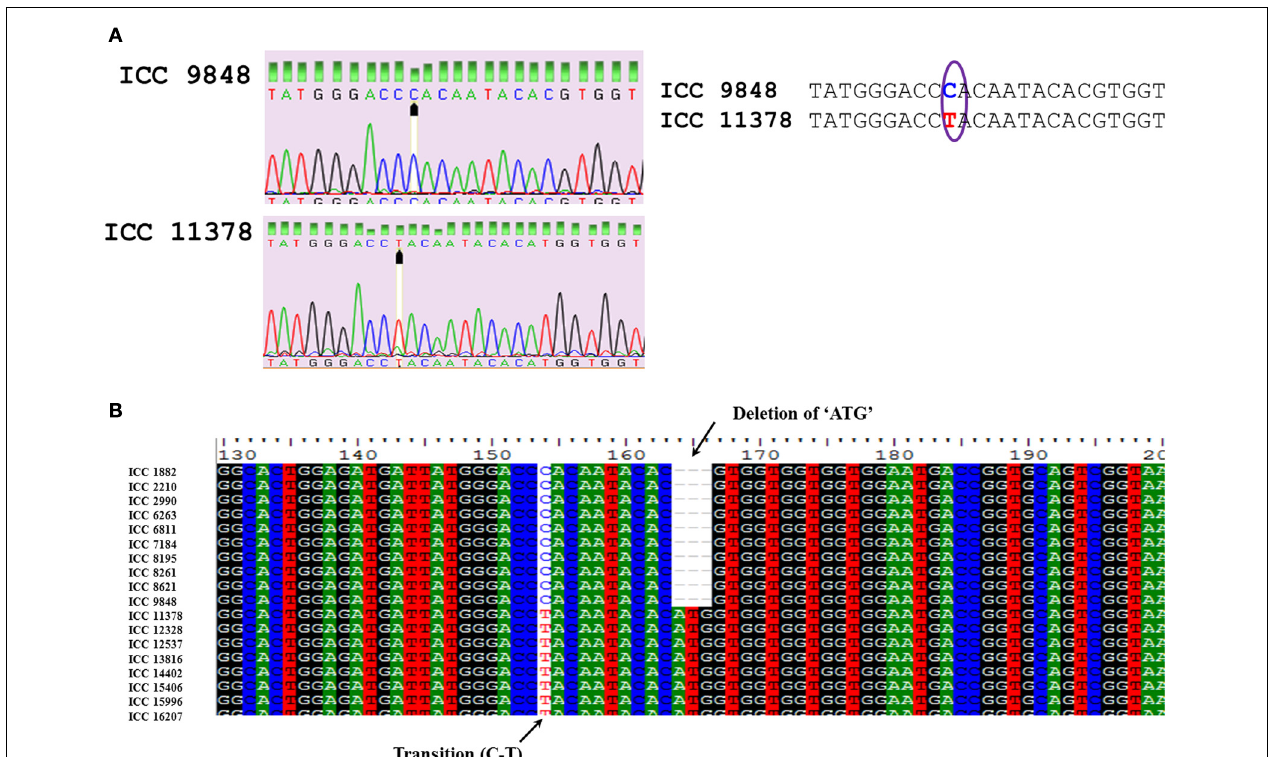
FIGURE 1 | (A) Comparison of sequence quality to confirm the true SNP using peak quality. The presence of SNP in DHN gene using sequence chromatogram is highlighted. (B) . Alignment of nucleotide sequences encoding DHN across various chickpea